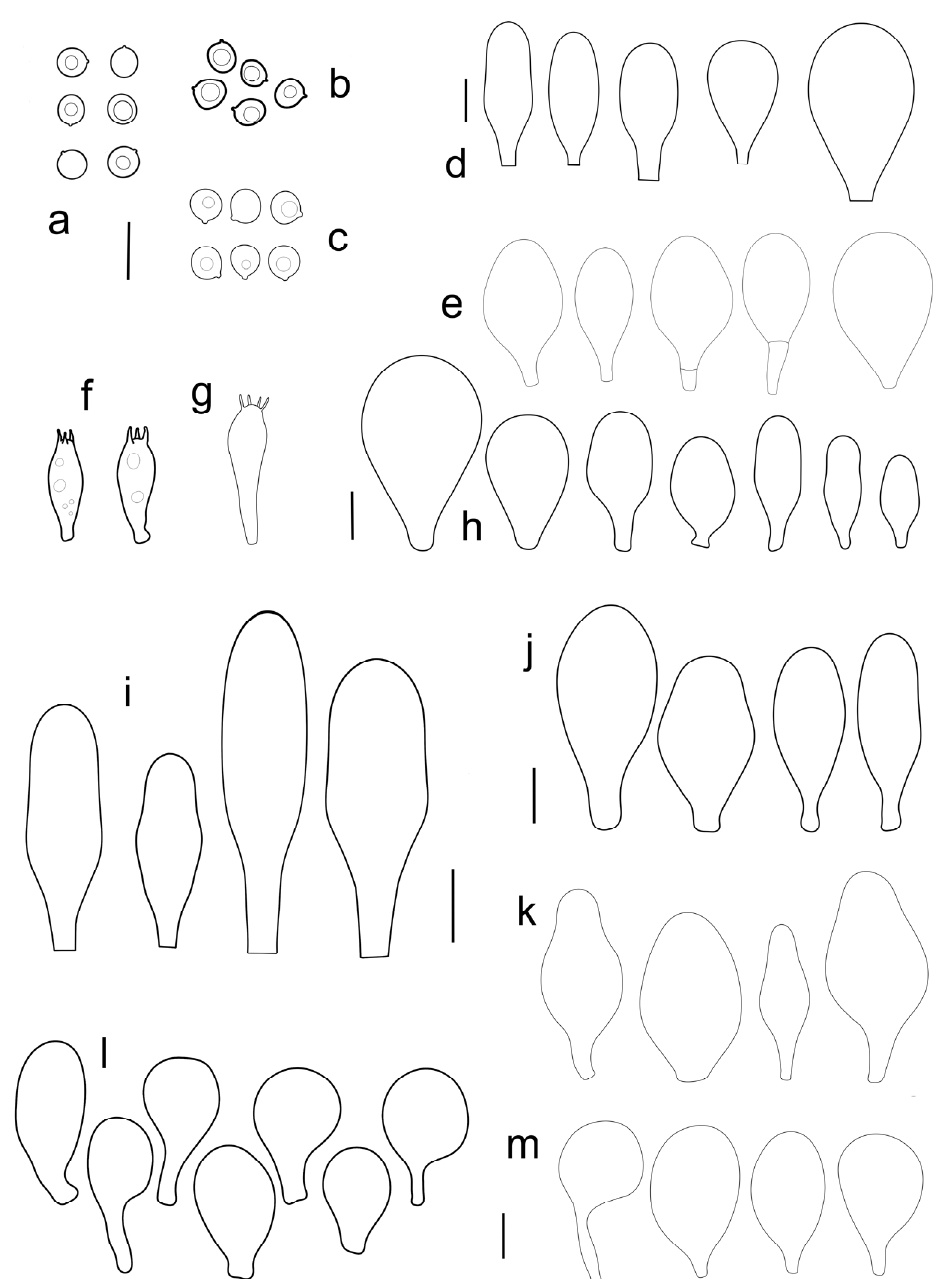
Figure 5. Pluteus romellii microcharacters: ( a – c ). basidiospores, ( a ). epitype BRNM 761731, ( b ). FG 18029 ( c ). LE 262701; ( d ). BRNM 761731 cheilocystidia; ( e ). LE 262701 cheilocystidia; ( f ). FG 18029 basidia; ( g ). LE 262701 basidium; ( h ). FG 18029 cheilocystidia; ( i – k ). pleurocystidia ( i ). BRNM 761731, ( j ). FG 18029, ( k ). LE 262701; ( l , m ). pileipellis elements ( l ). FG 18029, ( m ). LE 262701. Scale bars 10 µm.